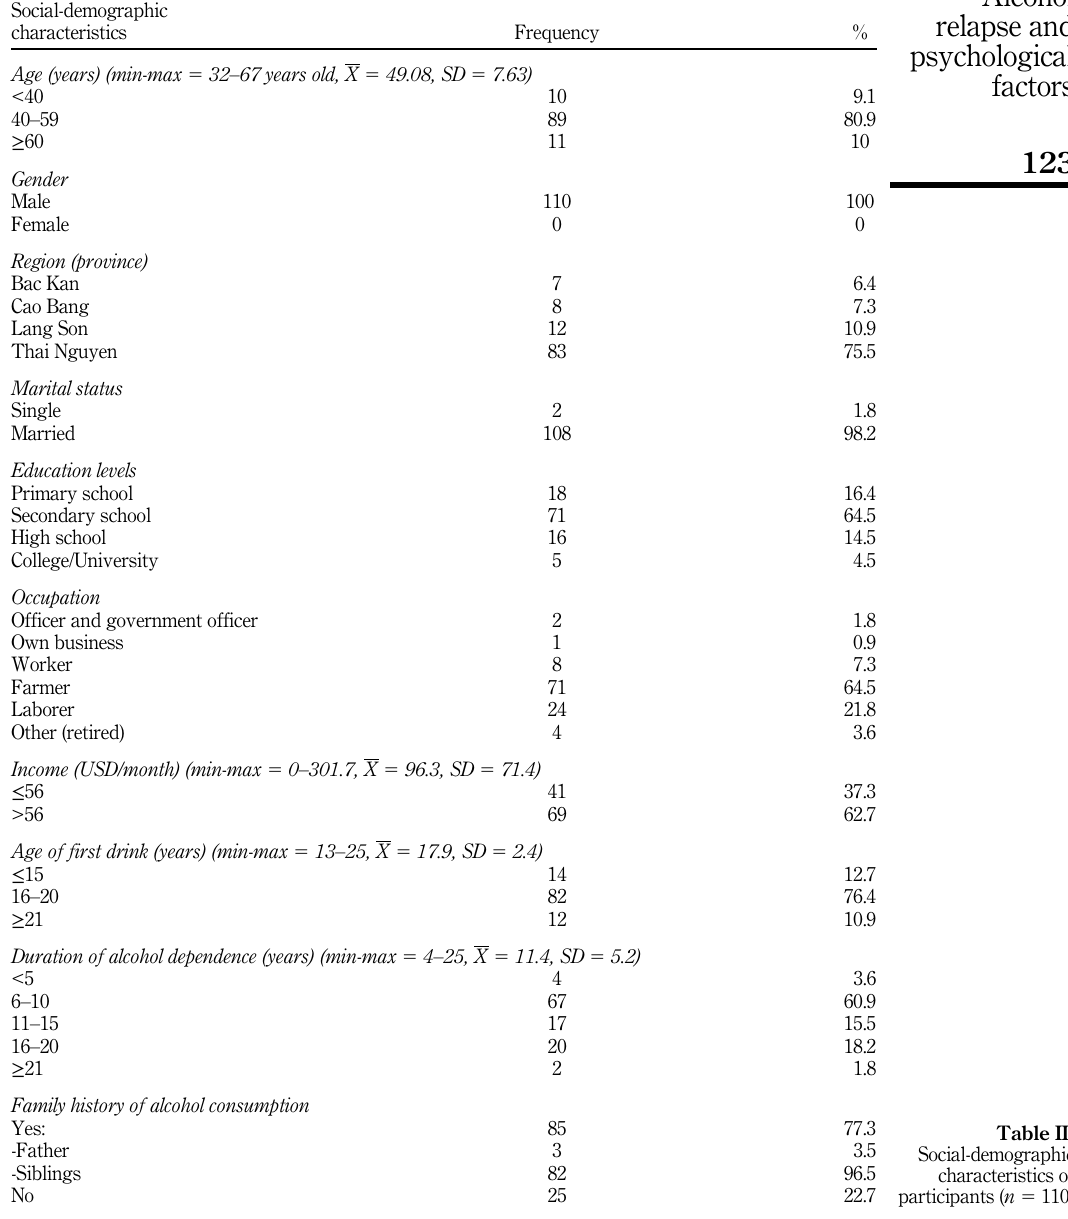
characteristics of participants ( n 5